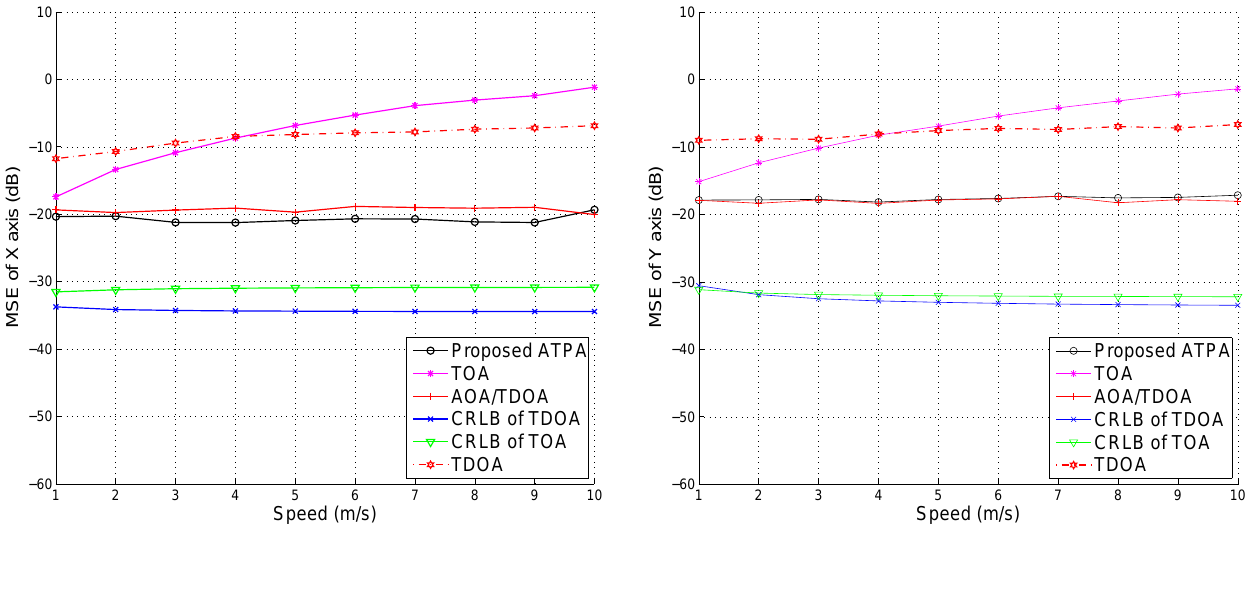
Figure 9. The effect of mobility on position